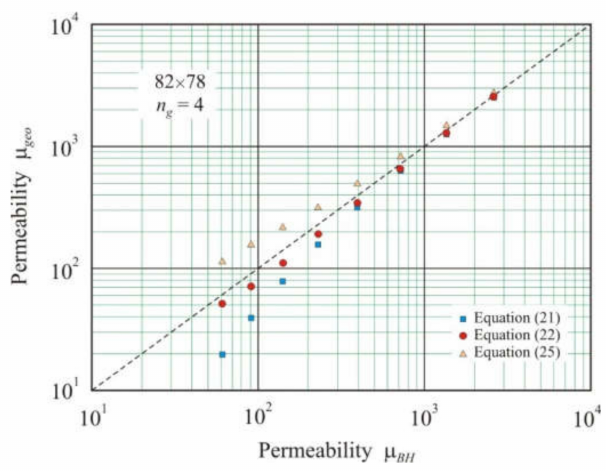
Figure 8. Relationship between geometric permeability µ geo calculated by Equations (21), (22), and (25) and effective permeability µ BH obtained using FEMM simulation in soft magnetic annuluses 82 × 78 mm with four air gaps and total length l g from 1 × 10 − 4 to 1.28 × 10 − 2 m. The dashed line corresponds to equation µ geo = µ BH